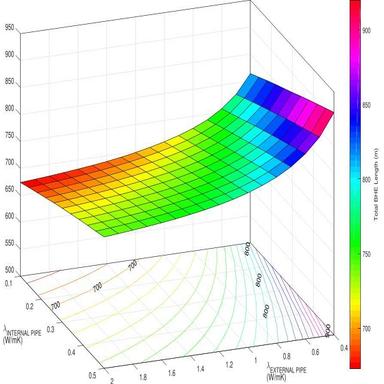
Graphic showing the simultaneous effect in the total length of a borehole field of varying the lPIPE in the outer and inner pipes of a coaxial system for an office building in a mild region with medium thermal conductivity of the ground. Isolines every 10 m.